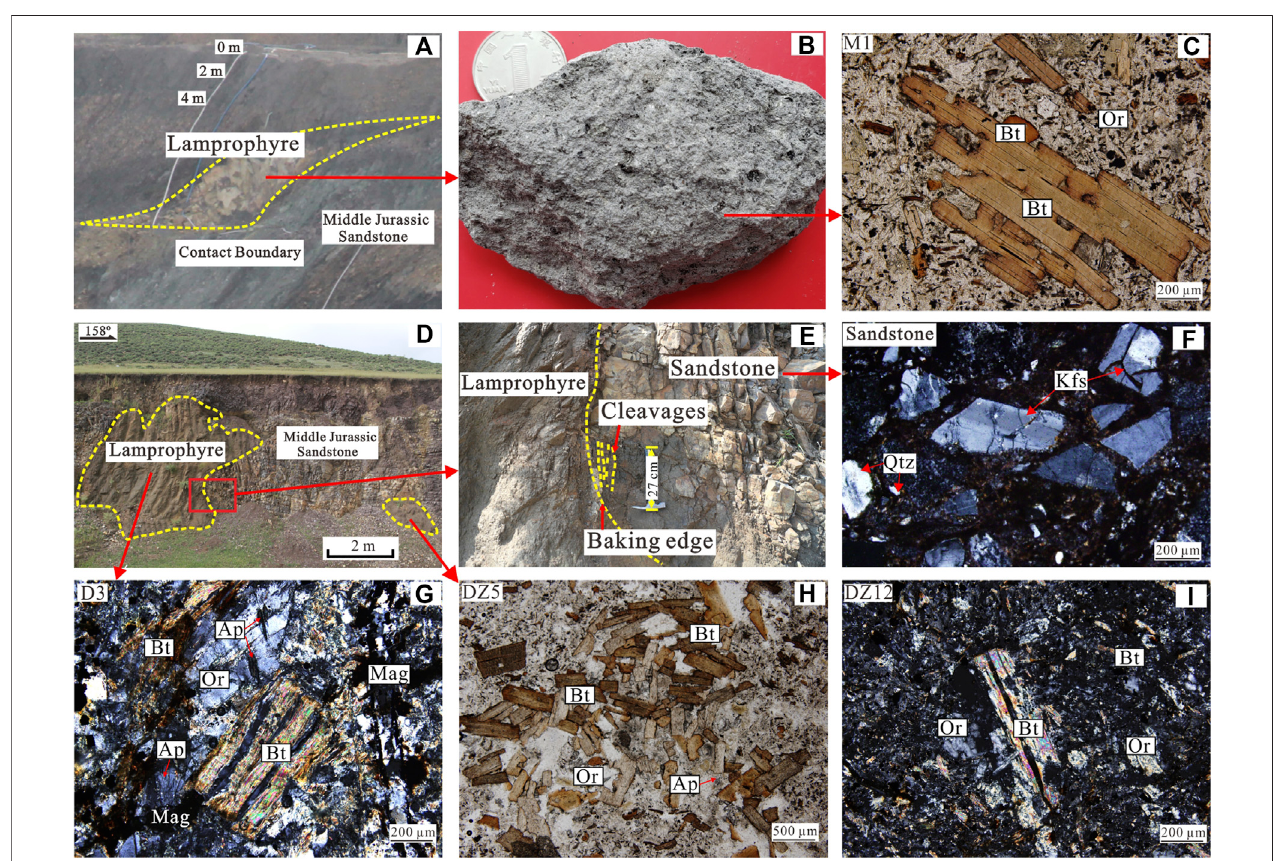
FIGURE2| LamprophyredikesoftheLateJurassicandtheEarlyCretaceous intrudedinthe MiddleJurassicsedimentarysequences. (A,D) Photographsofthe lamprophyredikesintrudedintotheJurassicsandstone; (B) Photographofthelamprophyrespecimen; (C) MicrophotographoftheJurassiclamprophyrewithtypical lamprophyric texture, mainly composed of biotite and orthoclase (named as BOL in this paper); (E) The contact between the lamprophyre and the surrounding rock; (F) MicrophotographoftheJurassicsandstoneintrudedbylamprophyres,mainlycomposedofquartzandfeldspar; (G – I) MicrophotographsoftheCretaceous lamprophyres with typical lamprophyric texture, mainly composed of biotite, orthoclase, magnetite, apatite, and tiny quartz crystals (named as QMLs in this paper). Bt, biotite; Or, orthoclase; Ap, apatite; Mag, magnetite; Pl, plagioclase; Qtz, quartz; Kfs, k-feldspar.